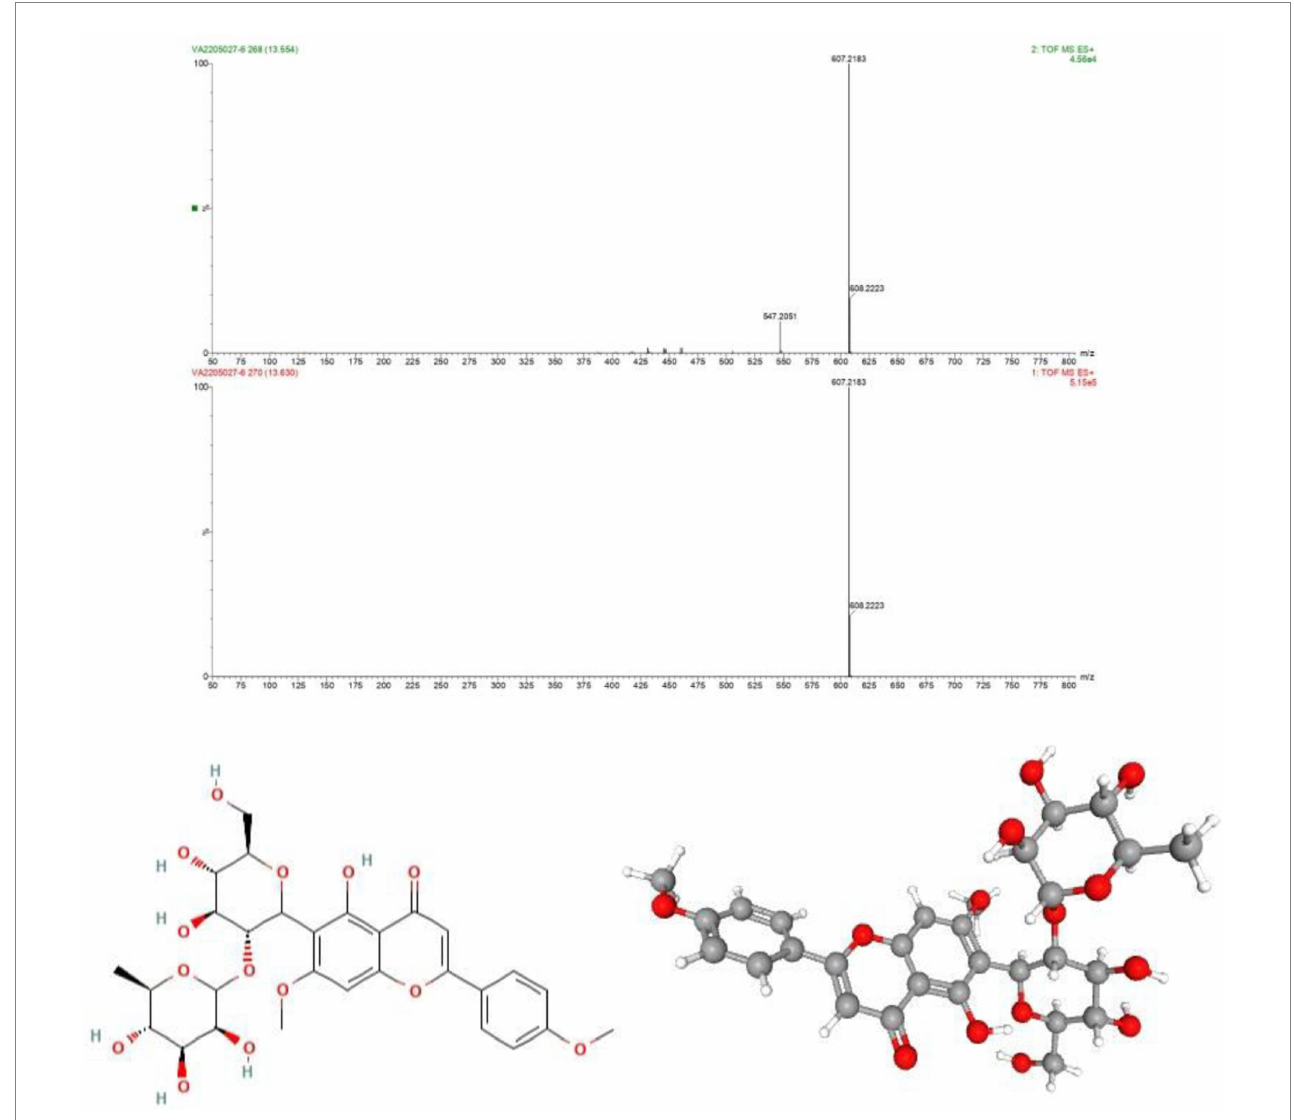
FIGURE 8 (A) Mass confirmation of Embinin, (B) 2D structure of Embinin, (C) 3D structure of